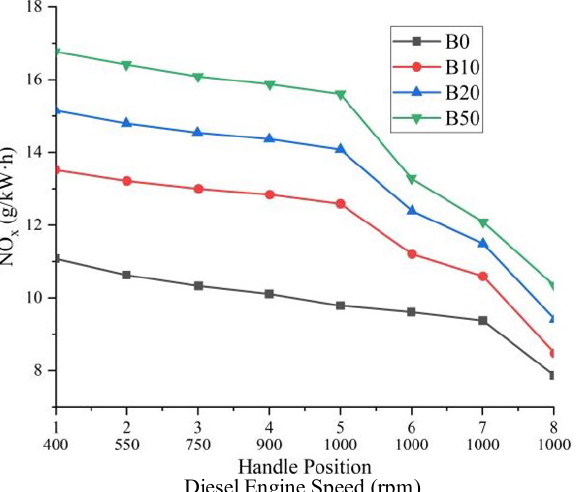
Figure 6. The NOx curves of biodiesel with different ratios under various working conditions.